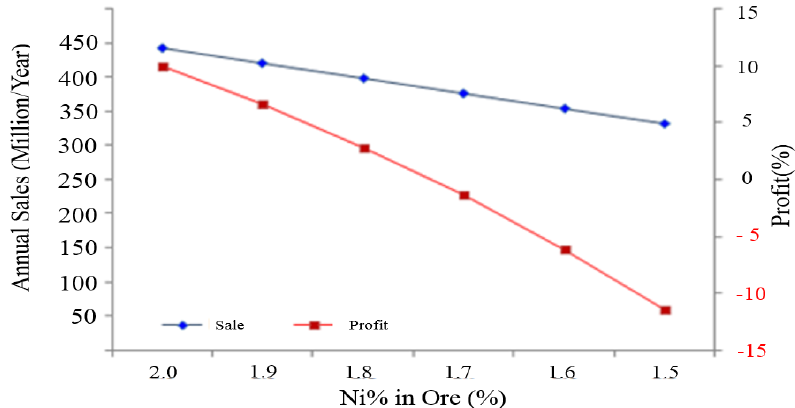
Figure 7. Effect of sales and profits by decrease of Ni composition.